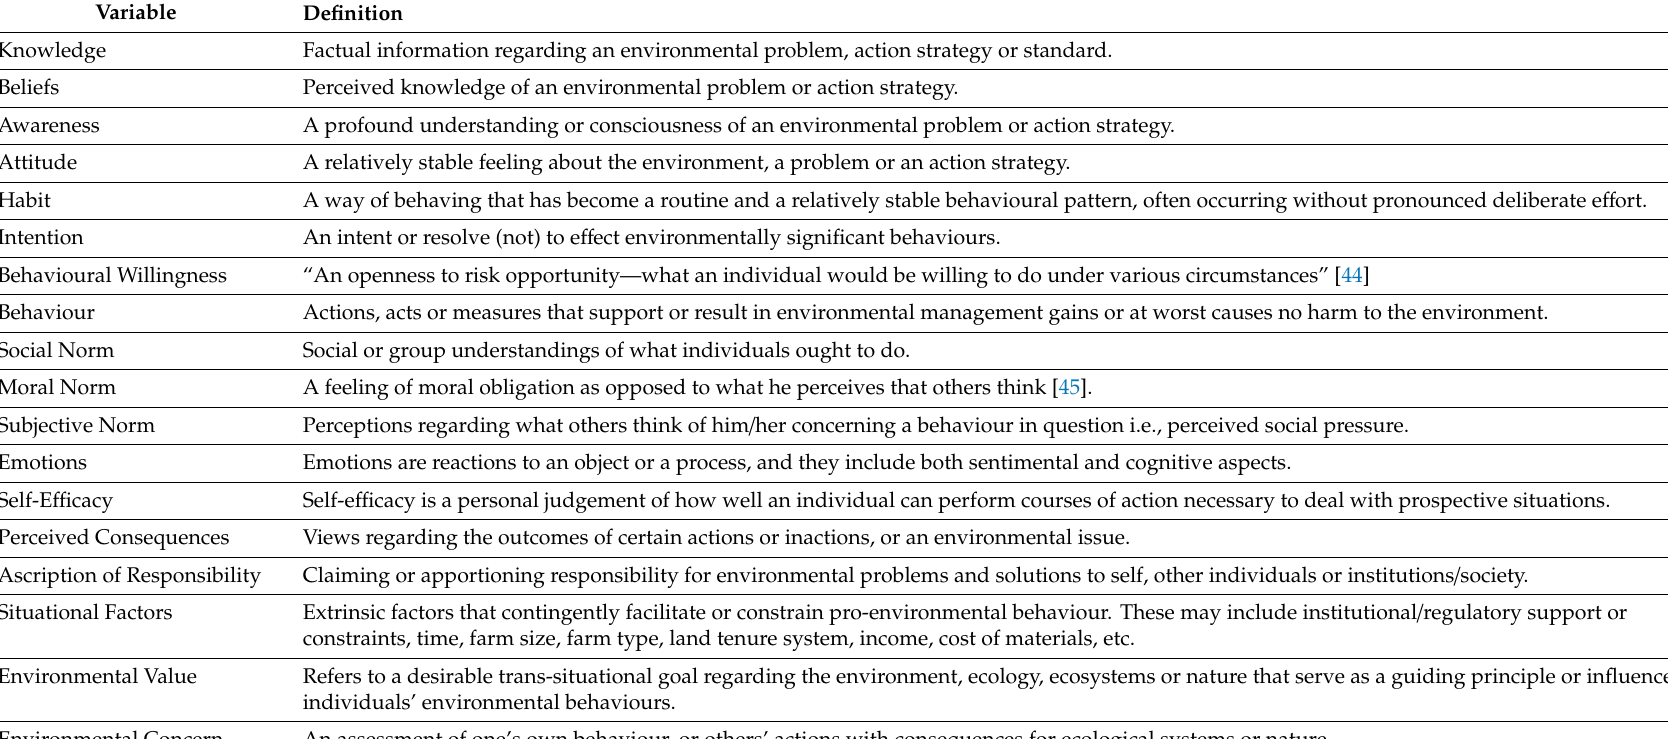
Table 1. Definitions of study variables.